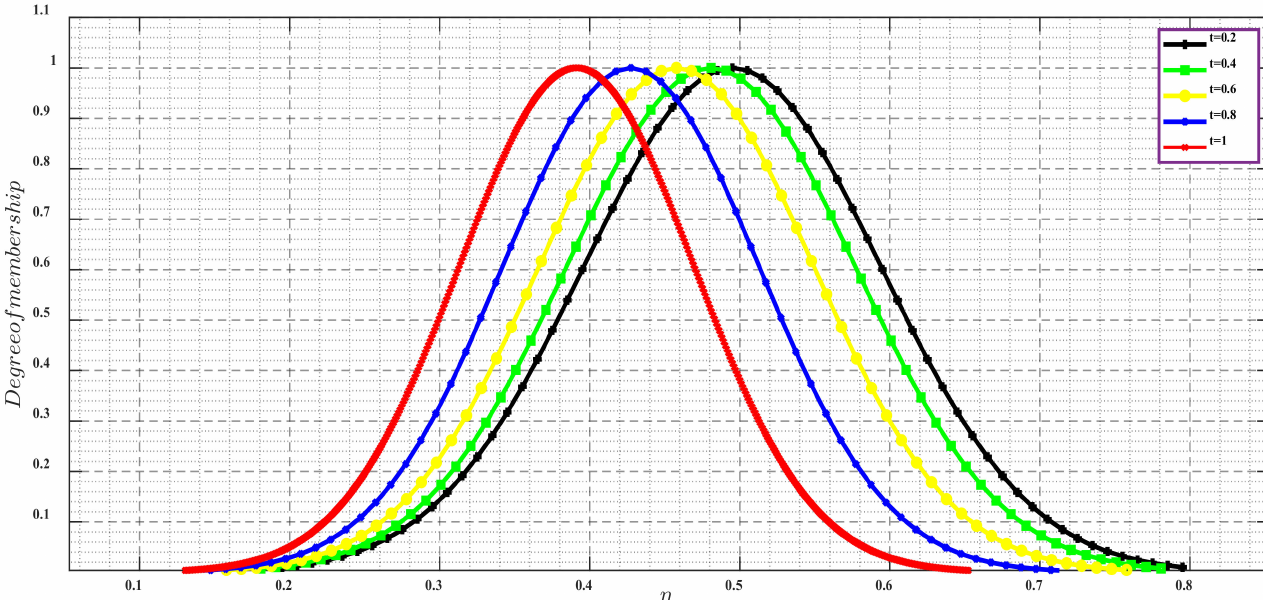
Figure 14. Fuzzy solution of η by SHPM for h = 0.2.